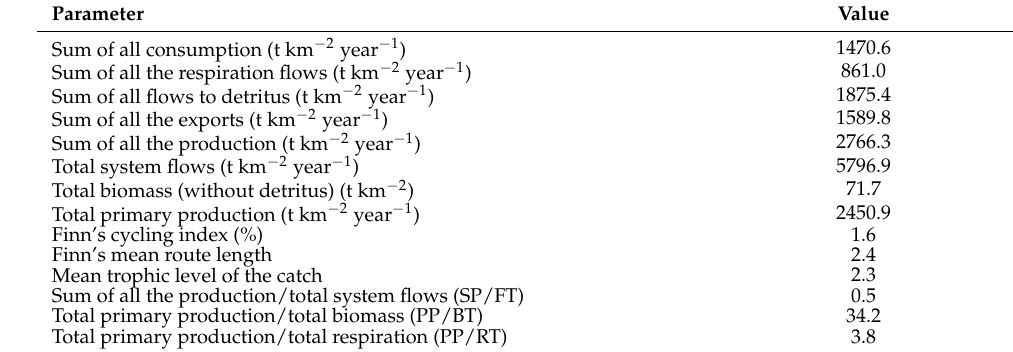
Table 3. Ecological indicators and estimated flow rates in the ecosystem of the Francisco Coloane Marine Area, Magellan Strait.